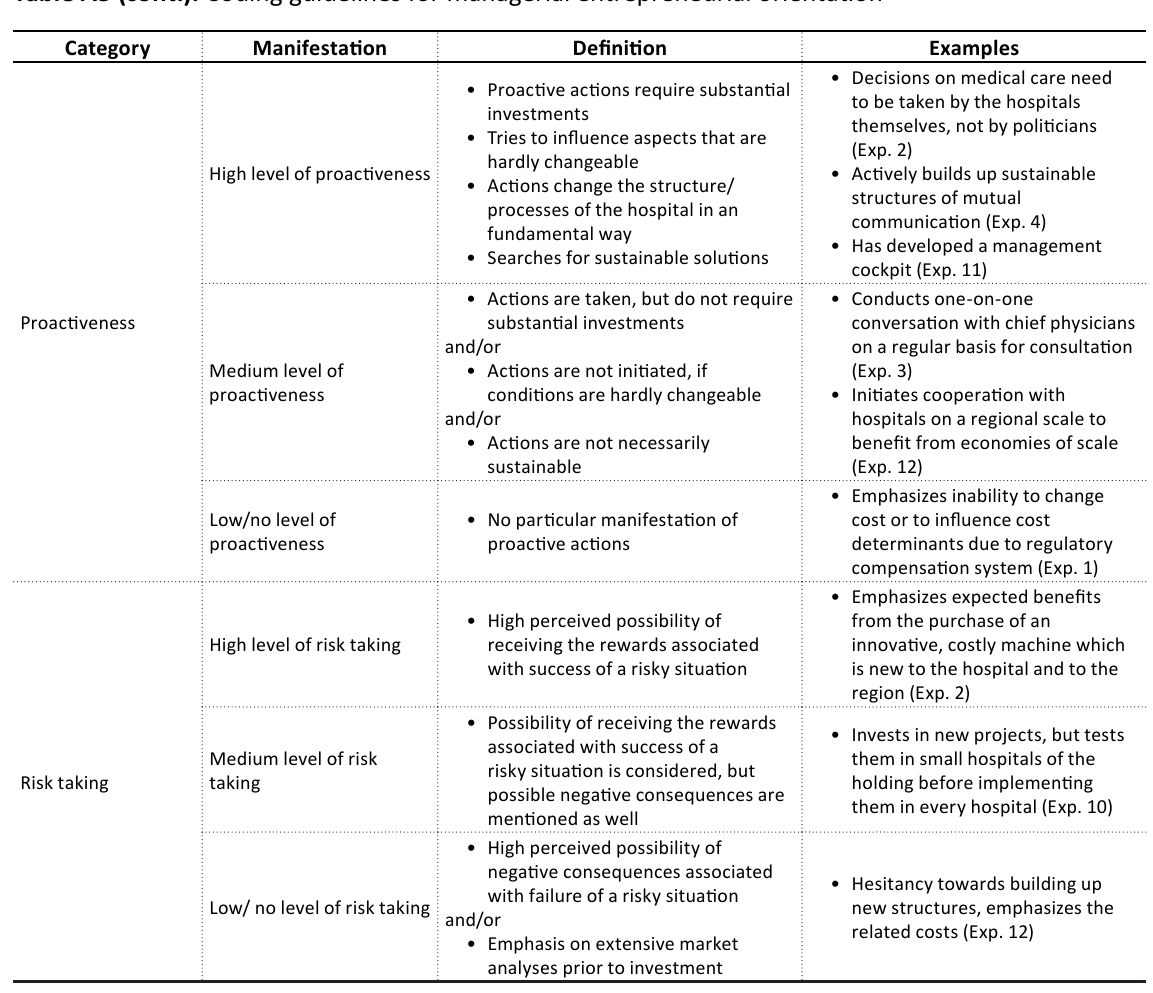
Table A3 (cont.). Coding guidelines for managerial entrepreneurial orientation